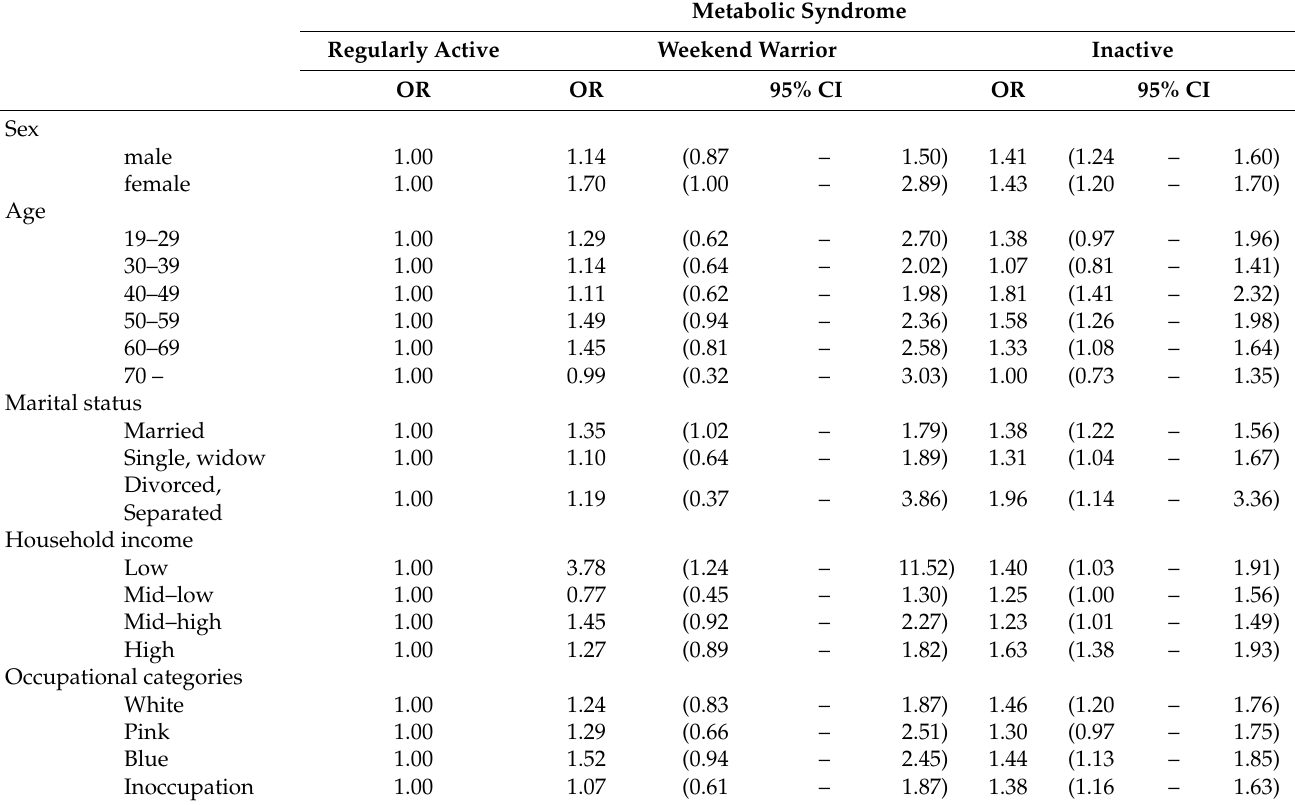
Table 3. Results of subgroup analysis stratified by independent